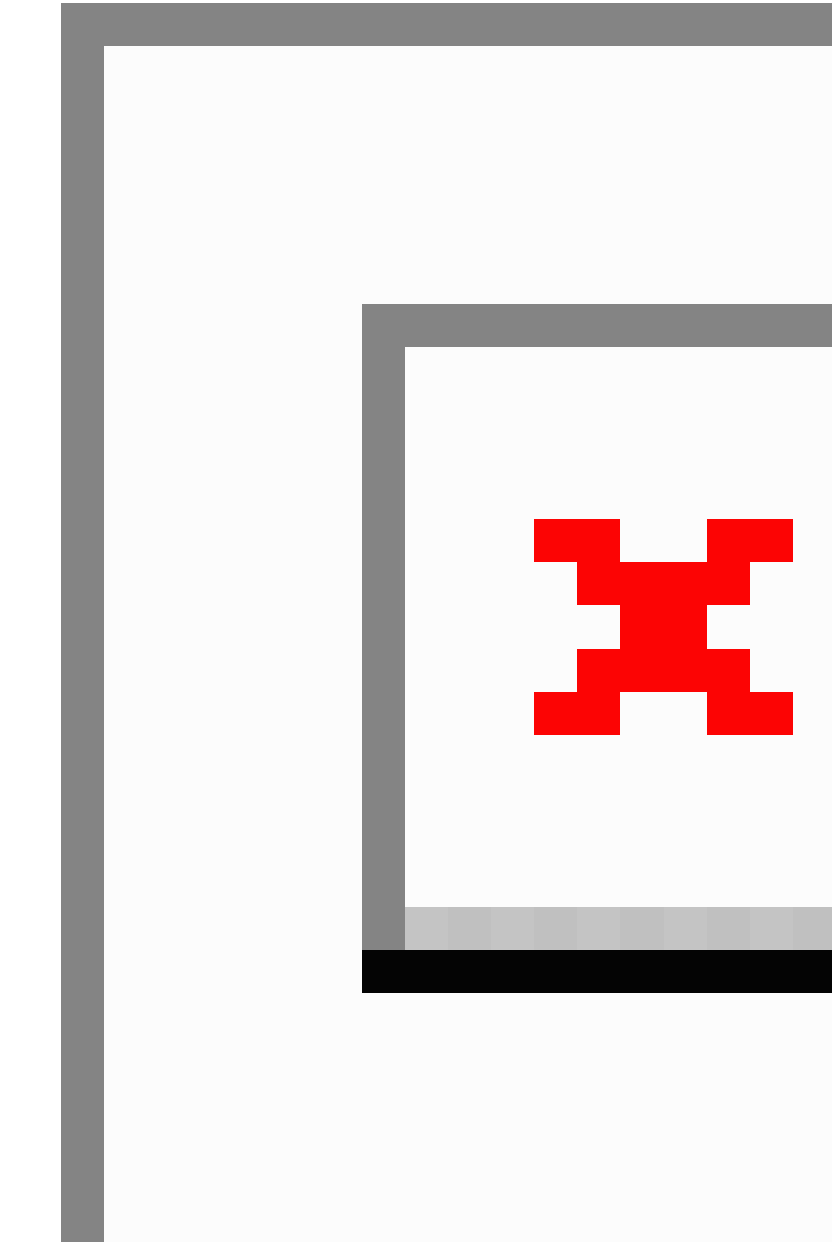
Figure 1. Example screenshots of interactions with the InDEx app. Top left to bottom right: normative feedback, personalized text message